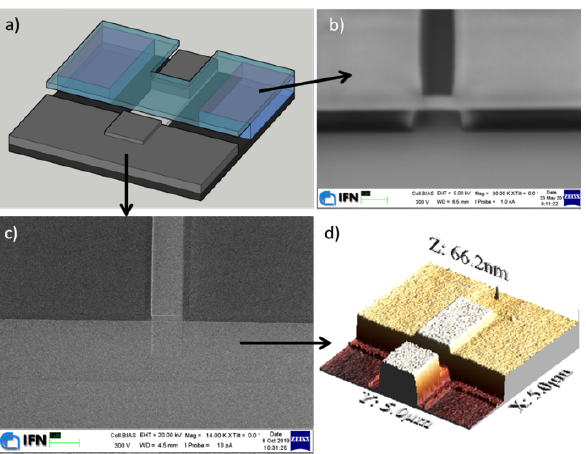
Figure 4. ( a ) Schematic image of the shadow mask evaporation technique. The copolymer/PMMA bilayer was exposed by EBL and developed, in order to obtain a self-standing bridge of the desired geometry, as shown by the scanning electron microscope (SEM) micrograph in ( b ). A two-angle evaporation with an oxidation step in between defines the junction geometry (light and dark gray in ( a ). ( c ) SEM micrograph of the junction after the lift-off process used to remove the bilayer mask. ( d ) An atomic force microscope (AFM) characterization of a typical junction.